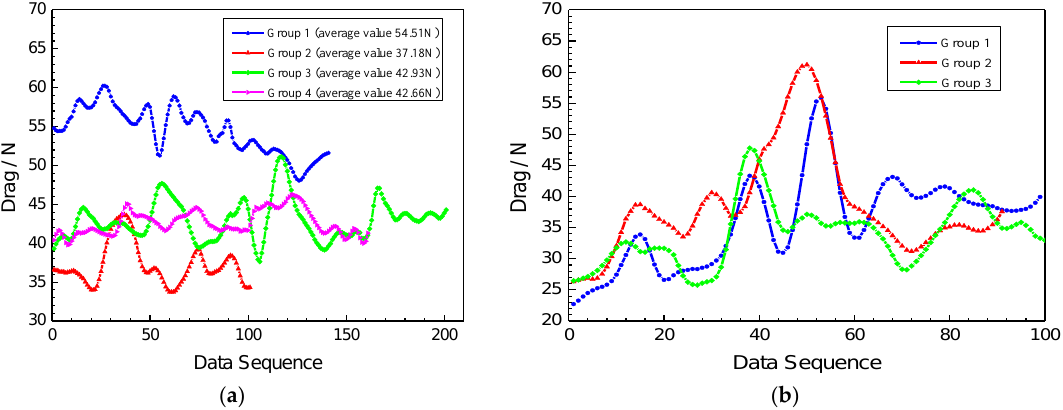
Figure 5. Local drag results of the packer in the horizontal hole: ( a ) In the smooth horizontal section; and ( b ) in the horizontal section with microsteps.